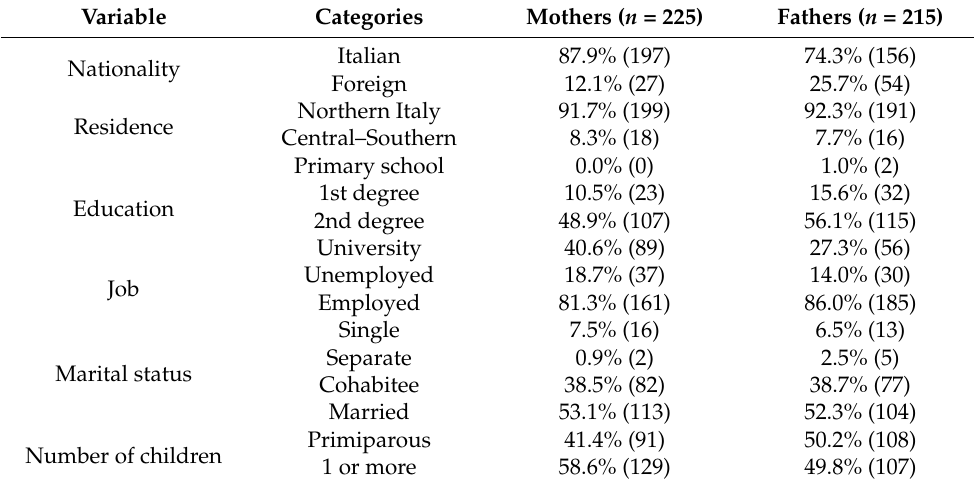
Table 2. Characteristics of the study sample by parent gender.